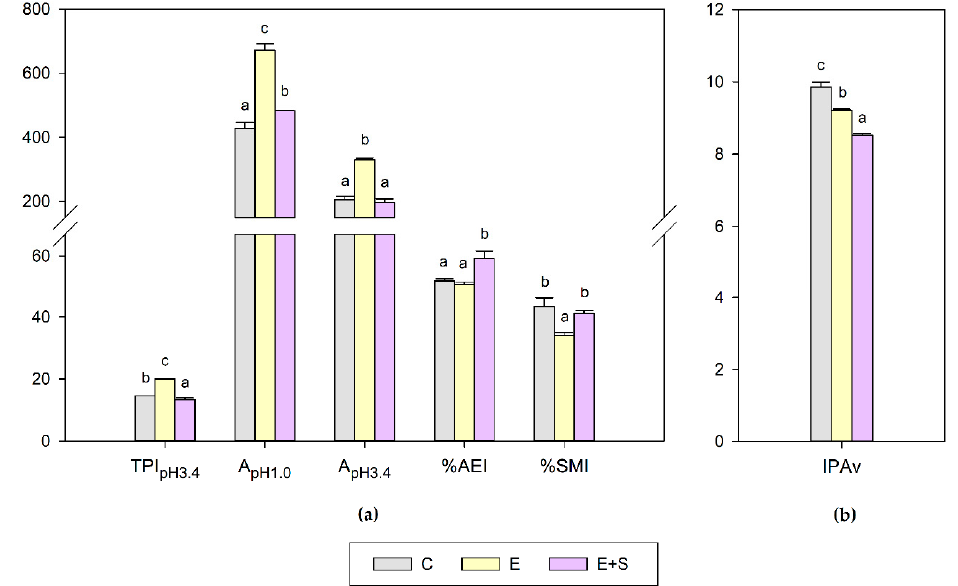
Figure 4. Phenolic ( a ) and aromatic ( b ) maturity determined in Bobal grapes on harvest day. C: control grapevines (untreated); E: grapevines treated by endotherapy; E + S: grapevines treated by endotherapy and spraying. ( a ): TPI (total phenol index); A (total anthocyanins, mg/L); %AEI (anthocyanin extractability index); %SMI (seed maturity index). ( b ): IPAv (varietal aroma potential index). All data are expressed as mean ± SD ( n = 4). For each parameter, different letters indicate significant differences according to the Tukey test ( p < 0.05).